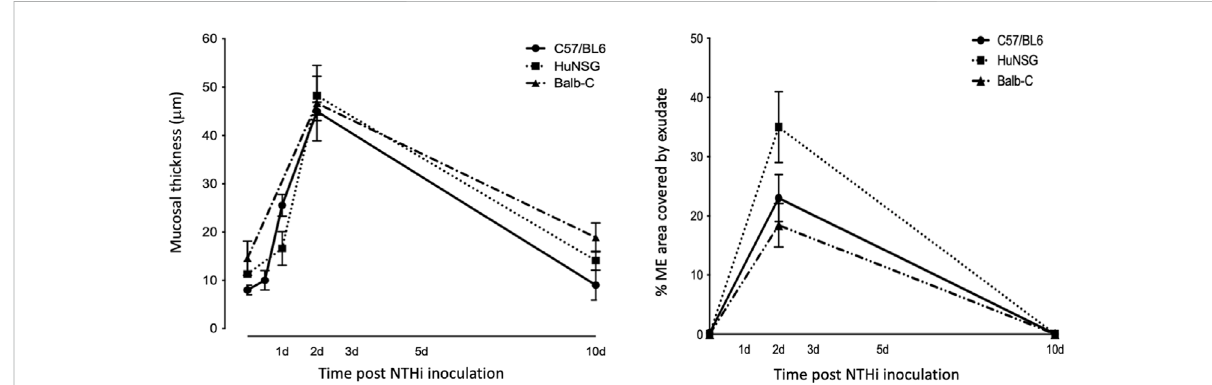
FIGURE 3 Quantitative comparison of mucosal hyperplasia and leukocyte in fi ltration in to the ME cavity post NTHi challenge. Both humanized mice and WT mice showed comparable mucosal hyperplasia and in fi ltration of the ME by leukocytes (% occupied area of ME by cells) 48 h after NTHi inoculation. All Balb/c, C57/BL6 and huNSG resolved OM by 10 days.